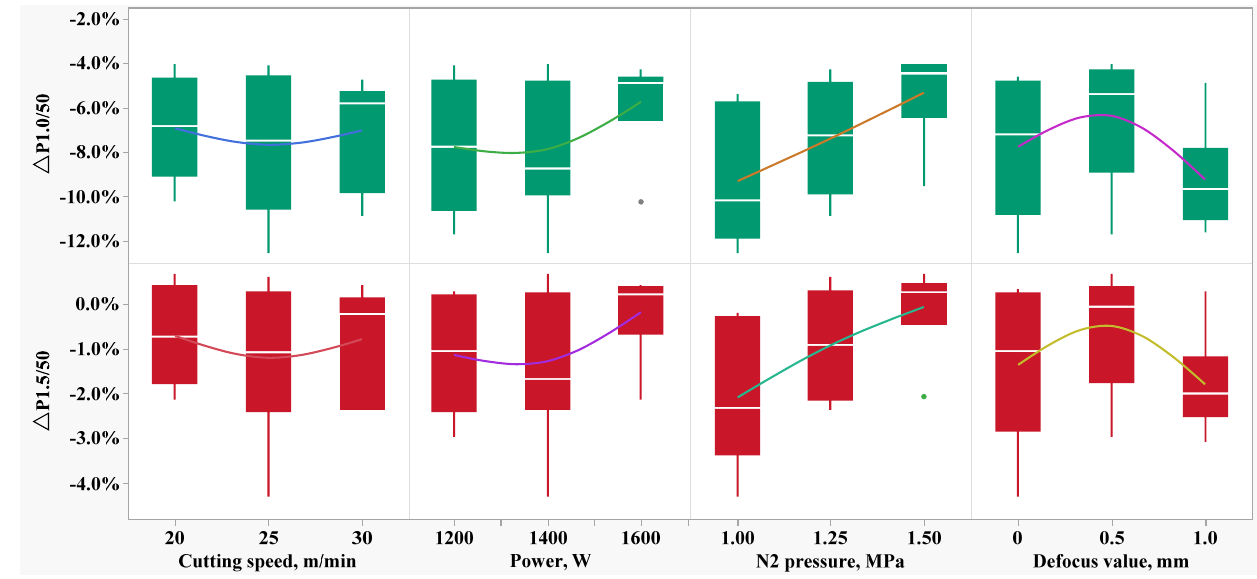
Figure 5. The effects of the individual laser cutting parameters on Δ P s.